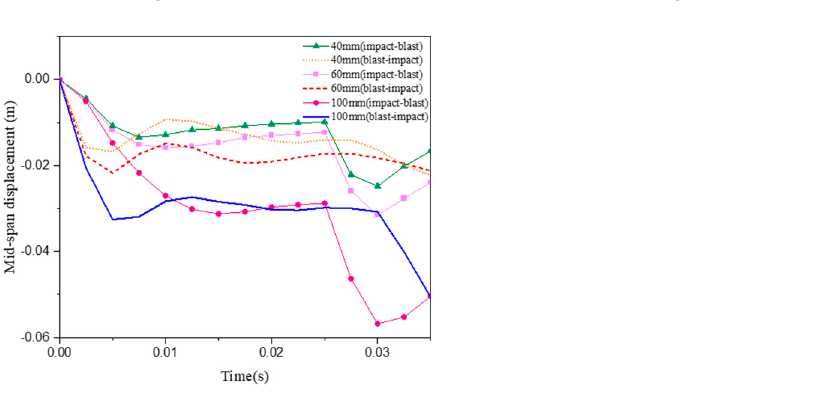
Figure 14. Time-history curves of mid-span displacement of beams under different longitudinal reinforcement spacing.